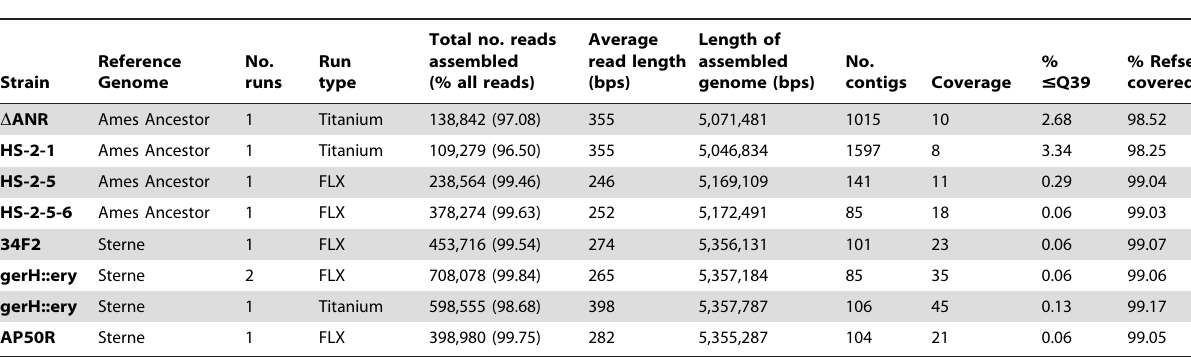
Table 1. Statistics of genome sequence of wild type and mutant B. anthracis strains.